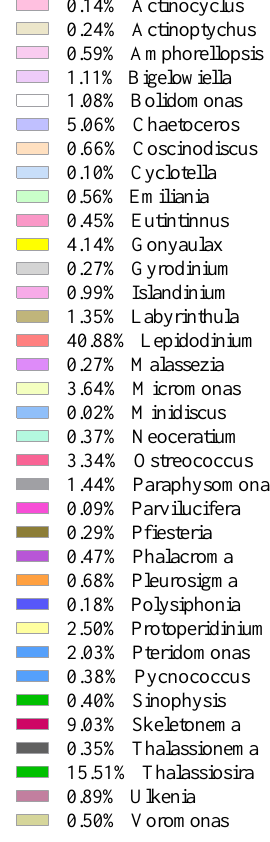
Figure 9. Phytoplankton relative abundance by 18S-rRNA gene metabarcoding analysis. The water sample was collected from Metri, Chile (−41°5967′, −72°7056′) on 24 April 2019, from 0–10 m depth. A total of 39,330 read pairs were obtained.